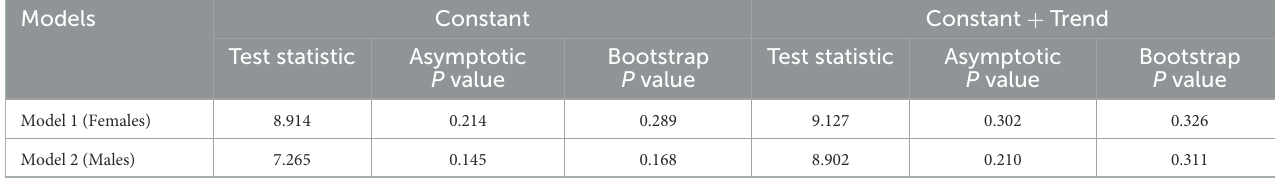
TABLE 6 LM bootstrap cointegration test. Models